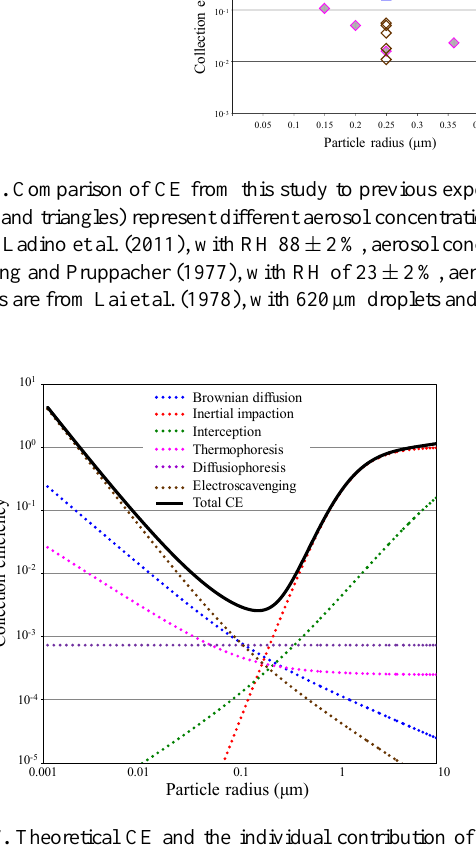
Figure 7. Theoretical CE and the individual contribution of each force. Calculation details are provided in the text. Experimental conditions of 400 elementary charges per droplet and one elemen- tary charge per particle are used for a variable aerosol size, a droplet radius of 21.6µm, an RH of 50% and room temperature.